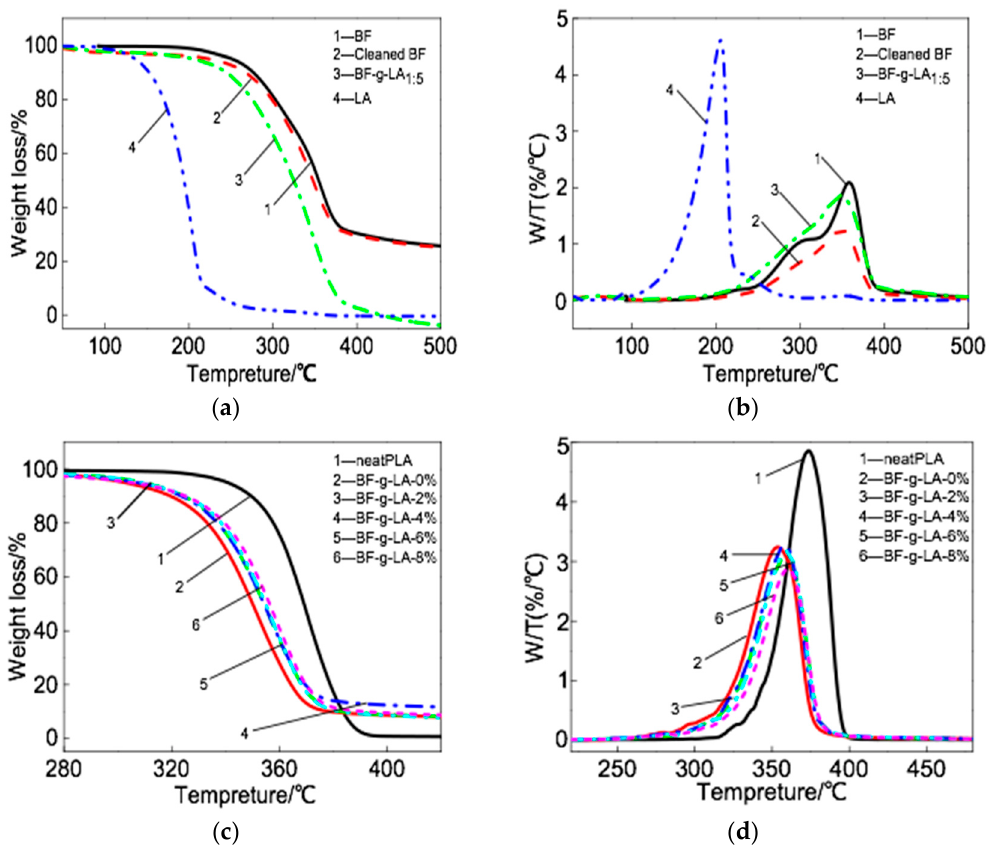
Figure 4. Thermal weightlessness curve for BF- g -LA and PLA/ BF/B- g -LA composites ( a ) TG curve for BF- g -LA; ( b ) DTG curve for BF- g -LA; ( c ) TG curves for PLA/BF/BF- g -LA composites; ( d ) DTG curve for PLA/BF/BF- g -LA composites. Table 5. Thermogravimetric temperature of BF- g -LA.